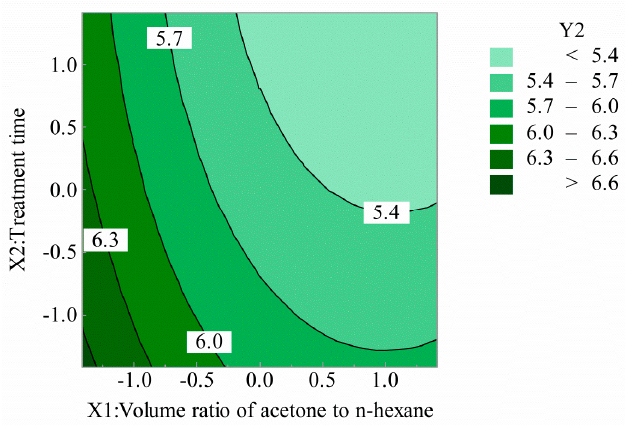
Figure 5. Volume ratio of acetone to n-hexane and treatment time for breaking strength (2D).